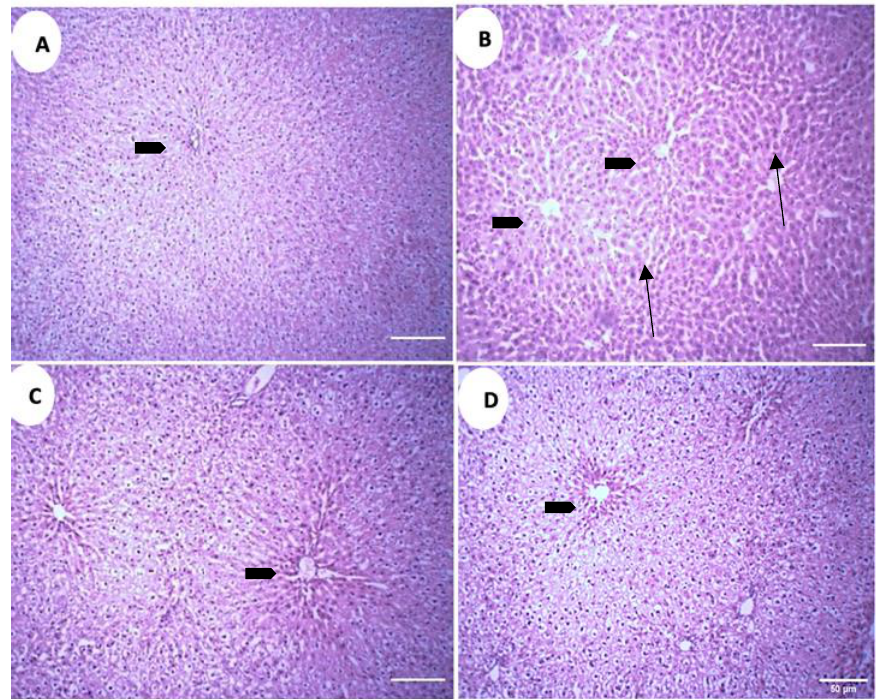
Figure 9. Representative photomicrographs of the liver parenchyma in different treatment groups. ( A ). Negative control group (NC). ( B ). Positive control group. ( C ). Treatment group 1 (GS1). ( D ). Treatment group 2 (GS2). Note the increase in the sinusoidal and perisinusoidal pace in the positive control group (PC) (arrows). Block arrow: central vein.